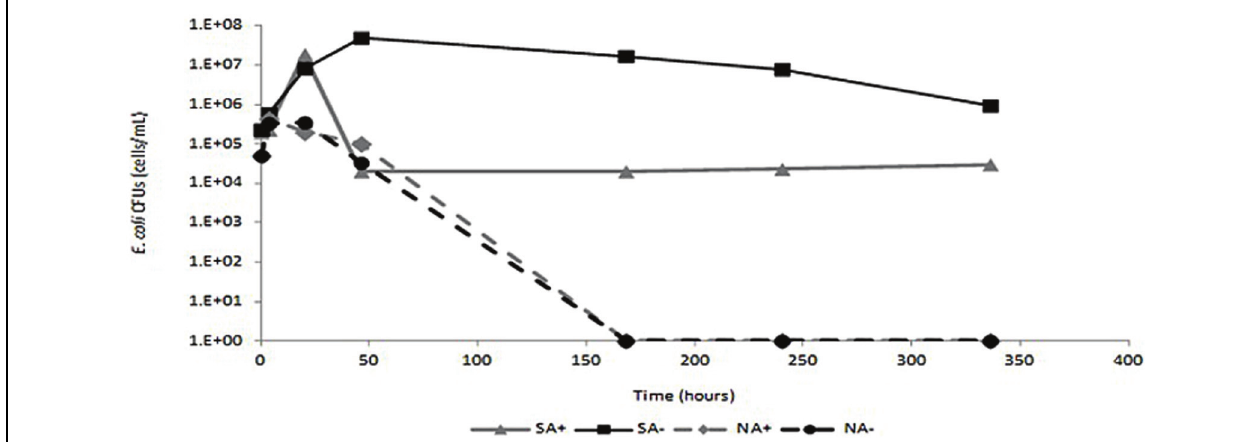
FIGURE 5 | Survival of Escherichia coli in sandy loam soil. Black line- non-amended soils; gray line- ceftriaxone-amended soils. Sterile soils are indicated by continuous lines and non-sterile soils are indicated by dashed lines. SA + indicates sterile ceftriaxone-amended soil; SA − indicates sterile non-amended soils; NA + indicates non-sterile ceftriaxone-amended soils; NA − indicates non-sterile non-amended